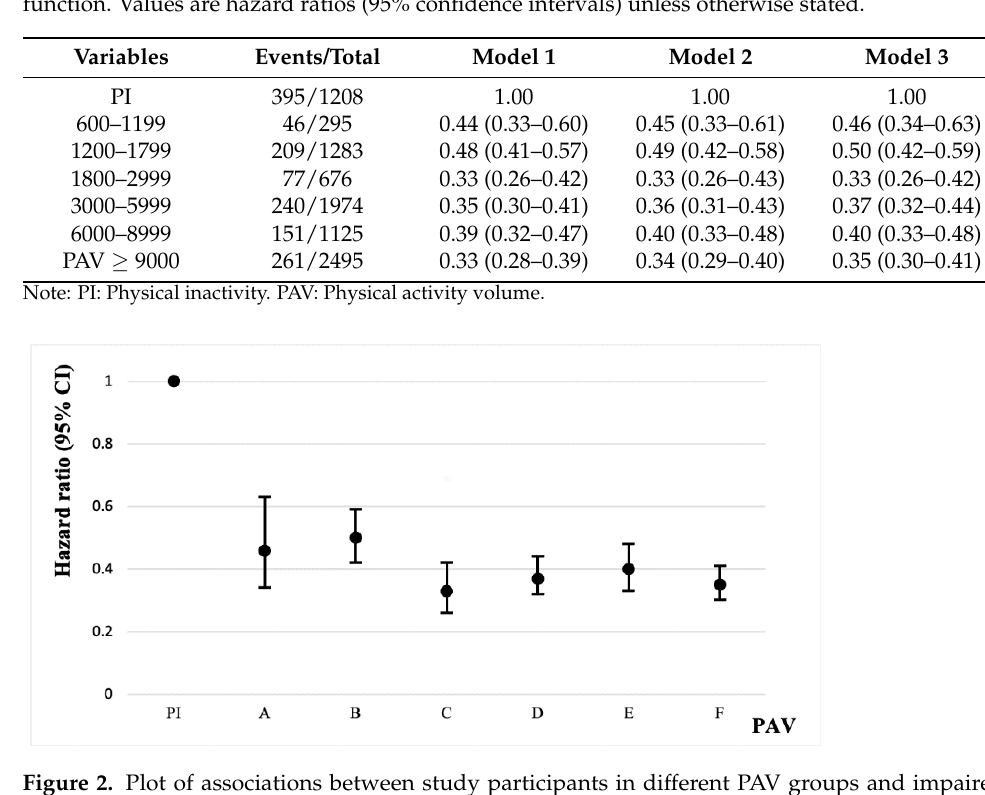
Table 3. Associations between study participants in different PAV subgroups and impaired physical function. Values are hazard ratios (95% confidence intervals) unless otherwise stated.